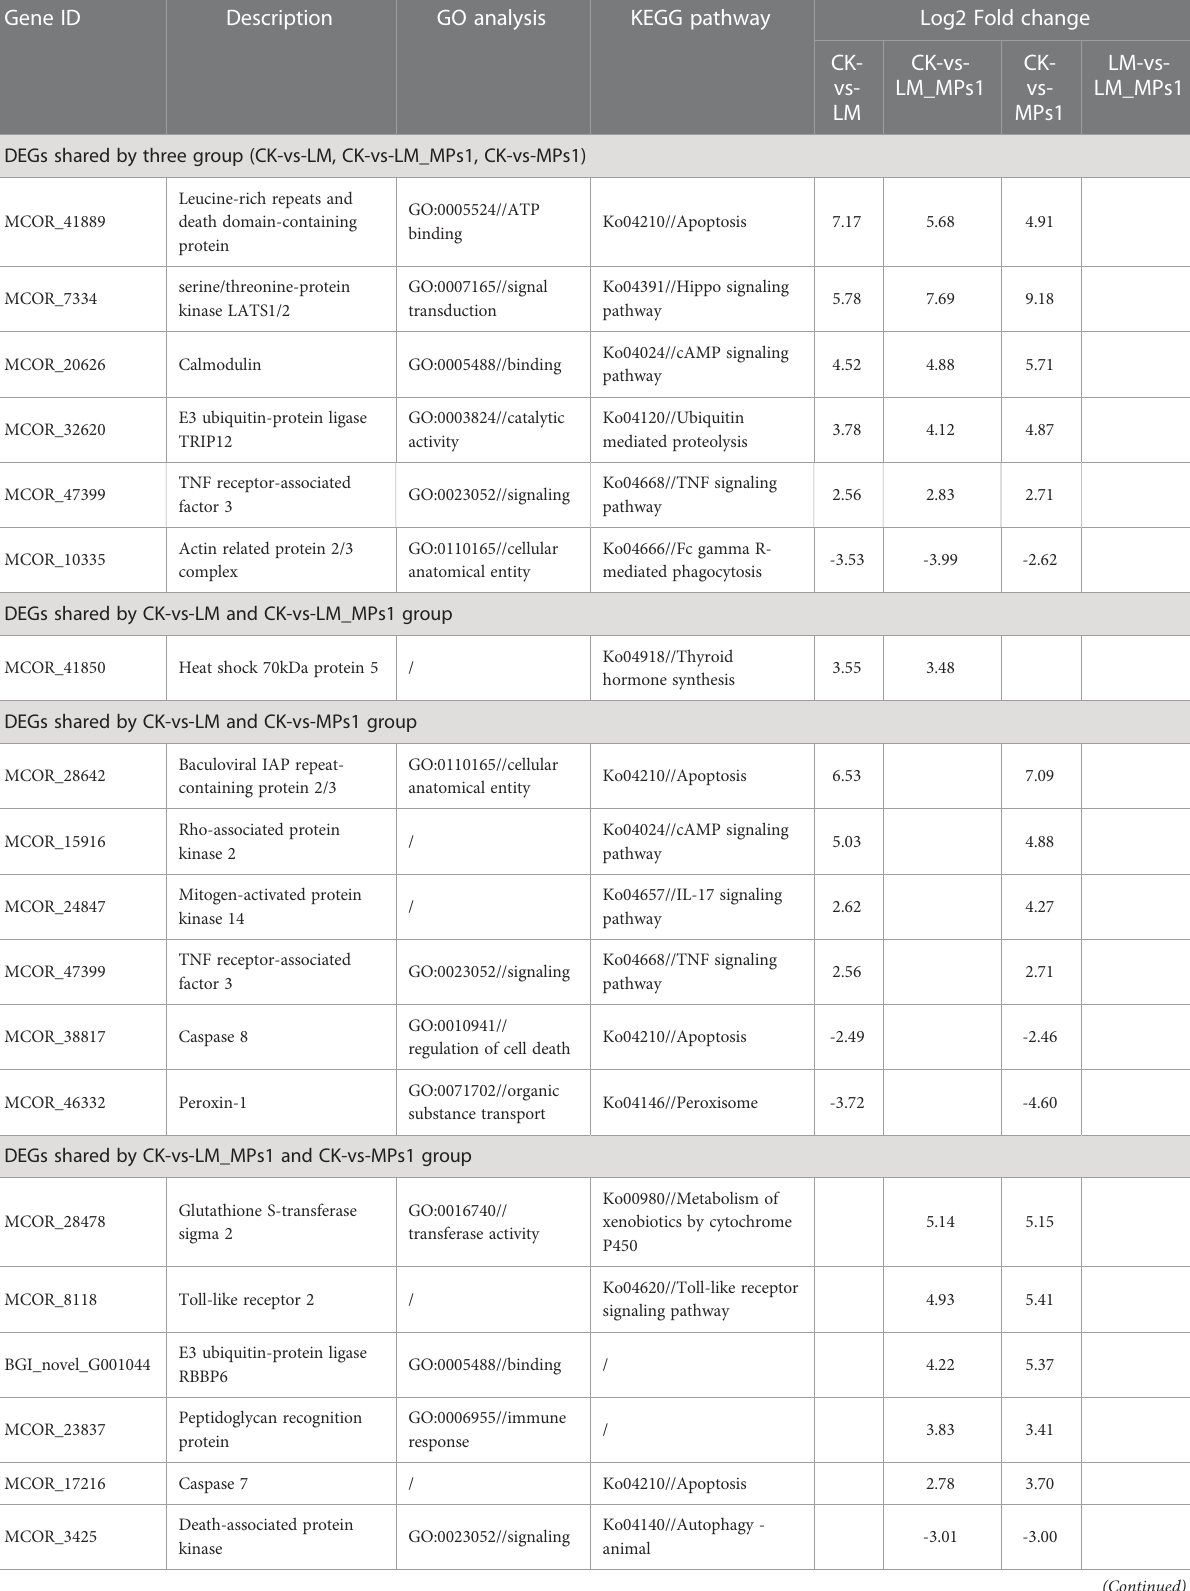
TABLE 1 The shared and unique DEGs of the digestive gland in M. coruscus among the different comparison groups. Gene ID